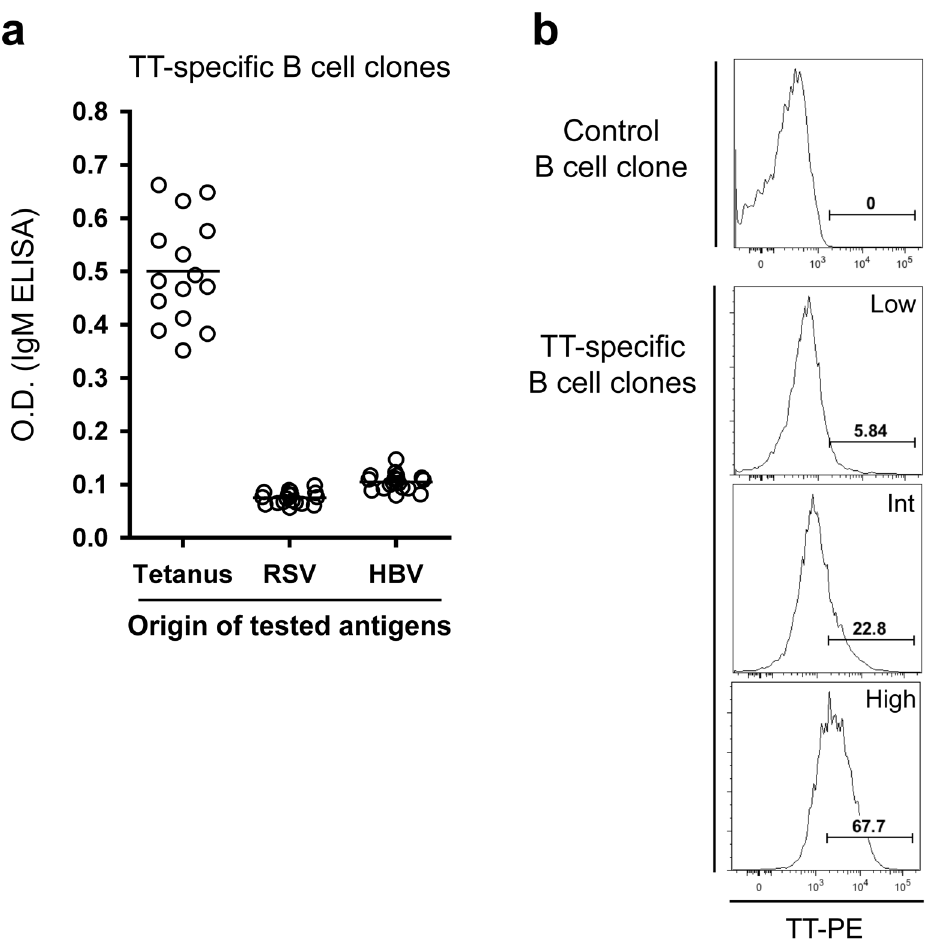
Figure 4. Characterization of the generated TT-specific human B cell clones. (A) After obtaining monoclonal TT-specific B cell lines, B cell clones were tested for cross-reactivity against unrelated antigens from HBV or RSV in an ELISA test. (B) The direct binding of phycoerythrin-labeled TT on TT ELISA positive B cell clones was determined by flow cytometry, and 3 sub-types of clones are observed: high, intermediate and low binding clones. Values in the histograms show the percentage of cells within the indicated gate.